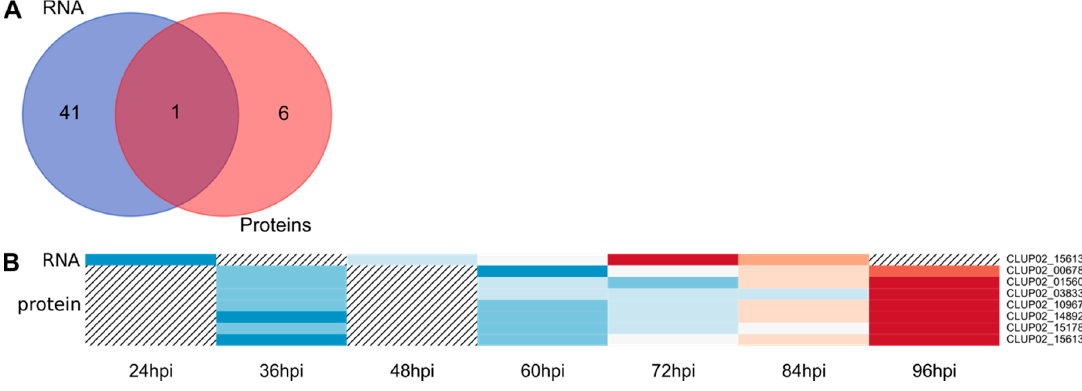
Figure 7. Overview of C. lupini expression and synthesis of transmembrane transporters. Venn diagram showing the overlap between DEGs and QPs associated with transmembrane transporter functions ( A ). Heatmap of the 7 candidate transmembrane transporters regarding their protein abundance and the corresponding transcript expression profile. Hatching areas indicate that data are not available ( B ). Colored bars indicated gene expression by Z-score calculated from normalized reads, and ranging from − 2 (downregulated gene, blue) to 2 (upregulated gene, red), or protein abundance by Z-score calculated from protein log10 abundance, and ranging from − 2 (lowest abundance, blue) to 2 (highest abundance, red).